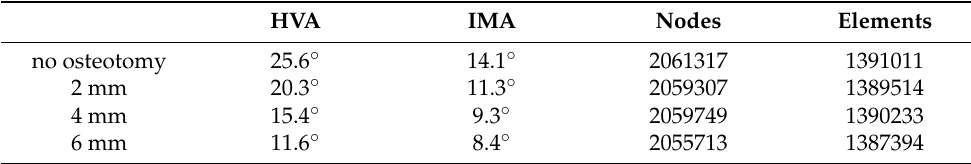
Figure 3. ( a – d ) Four models of distal metatarsal displacement were performed with no osteotomy, and the displacement of osteotomy was 2 mm, 4 mm, and 6 mm. Table 2. The number of units and HVA, IMA. Table 2. The number of units and HVA,